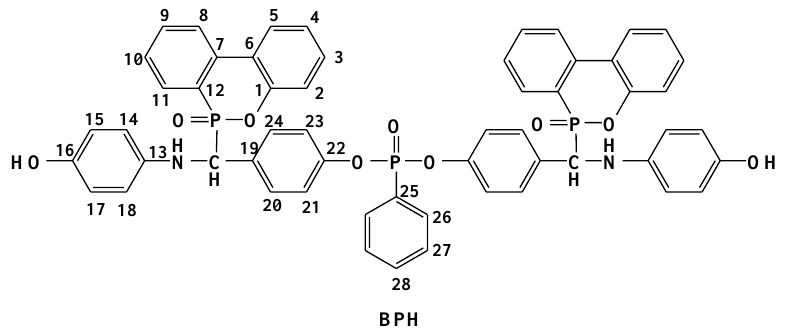
Figure 2. Chemical structure of BPH bisphenol.